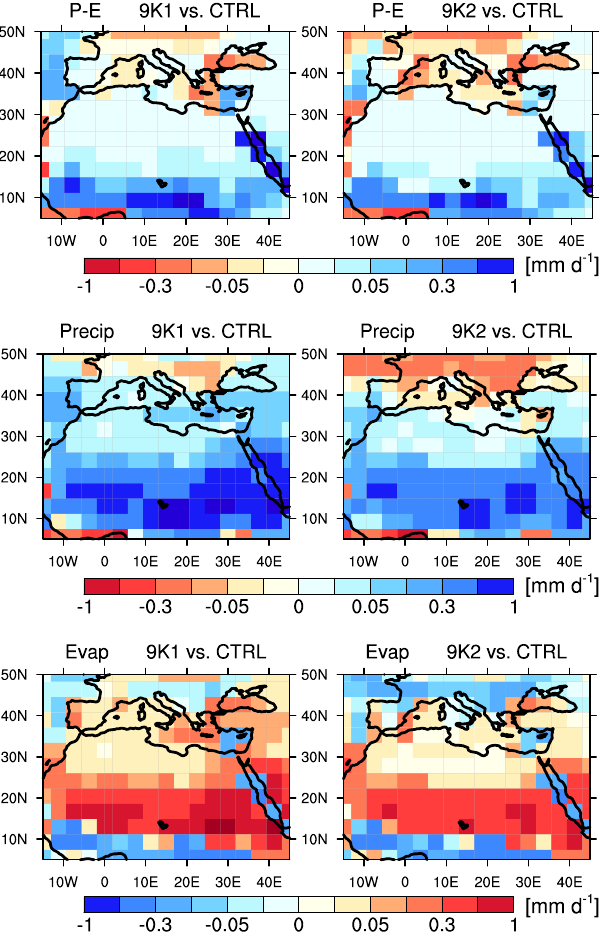
Fig. 8. Annual mean anomalies of P - E , P and E from global sim- ulations, 9K1 vs. CTRL (left) and 9K2 vs. CTRL (right).